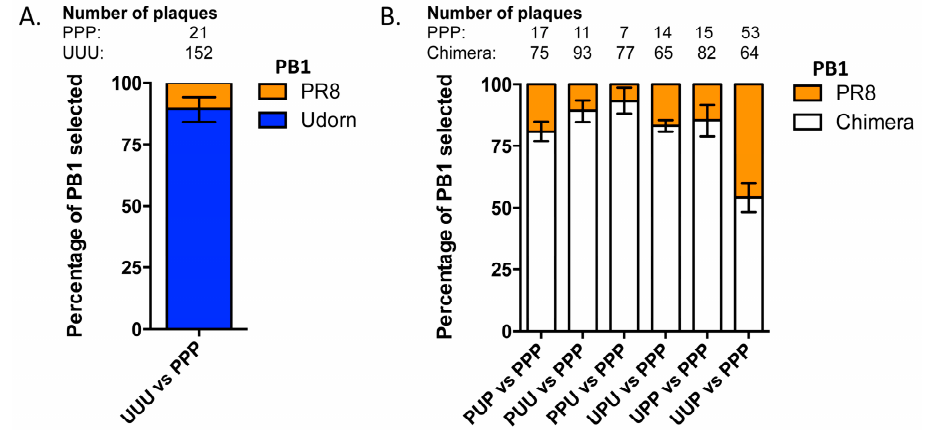
Figure 3. Frequency of competing genes incorporated in progeny viruses resulting from nine ‐ plasmid competitive transfection assays. Nine ‐ plasmid competitive transfections were performed on a PR8(Ud ‐ NA) background competing ( A ) wild ‐ type PR8 (orange) and Udorn (blue) PB1 genes or ( B ) the wild ‐ type PR8 PB1 gene (PPP; orange) against chimeric PB1 genes (white) as indicated. The origin of the PB1 gene segment from a random selection of progeny plaques was determined by gene ‐ specific RT ‐ PCR. Total numbers of specific plaques determined from each competition are indicated. The data represent the mean and standard error of 3–5 individual experiments.